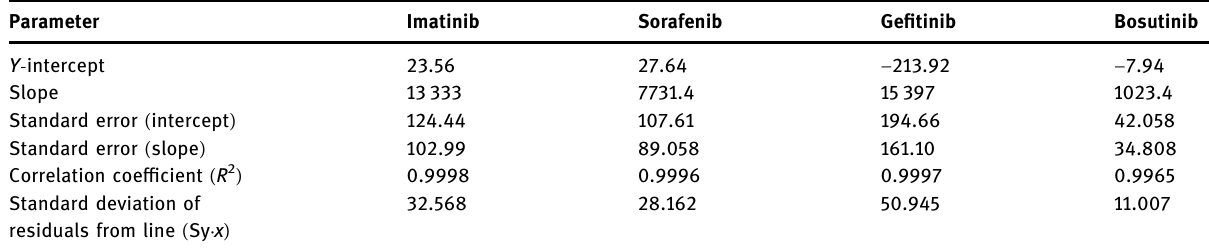
Table 1: The linearity data of the proposed conductometric method Parameter